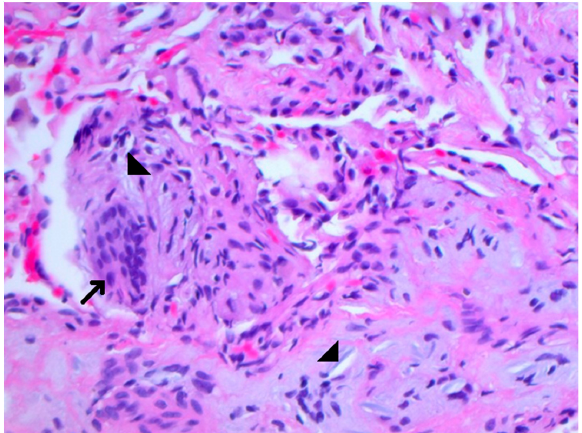
Figure 2. The transbronchial lung biopsy showing perivascular multinucleated foreign body giant cells (arrow) containing refractory material consistent with microcrystalline cellulose material (arrowheads). Formalin fixed paraffin embedded sections of a transbronchial lung biopsy are stained with Hematoxylin and eosin ×400 (H&E ×400).